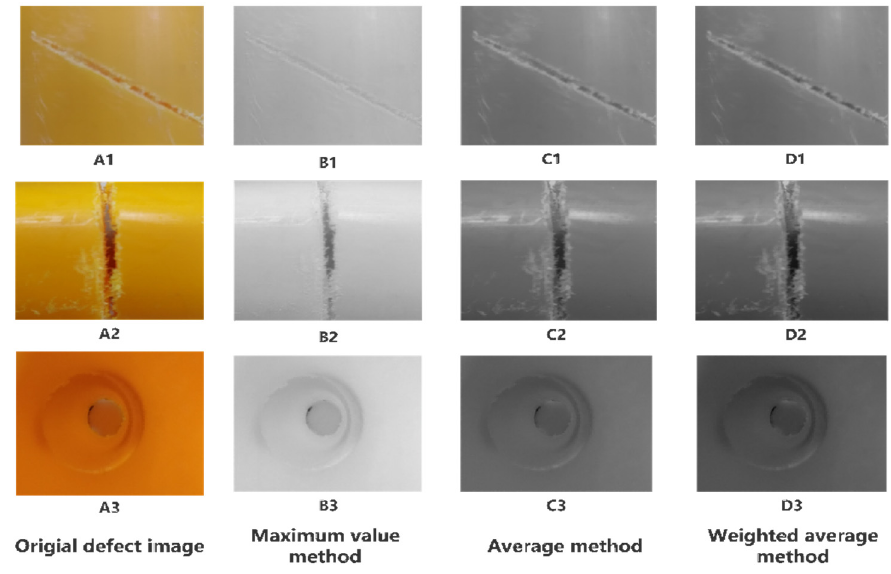
Figure 2. Comparison of grayscale processing methods for pipe defect images.